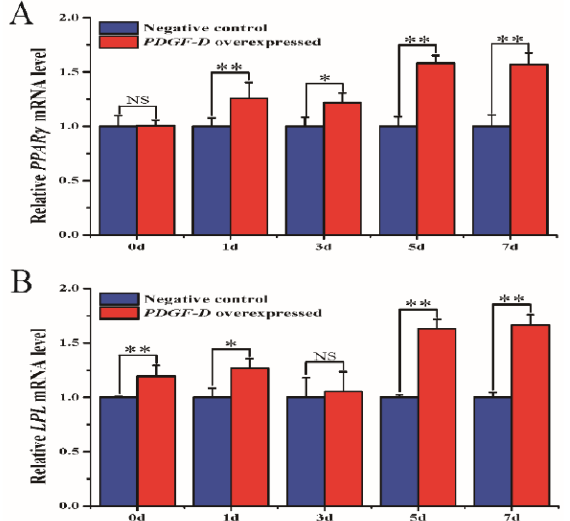
Figure 2. mRNA expression of the PPAR γ and LPL genes. ( A ) mRNA expression of the PPAR γ gene. ( B ) mRNA expression of the LPL gene. * p < 0.05, ** p < 0.01, NS: no significant difference.